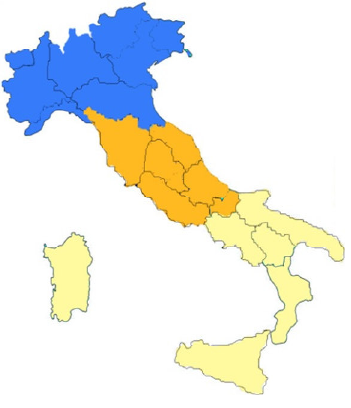
Legend Upper panel. The mortality rate in the south (9.3 ± 0.8%) and central regions (10.3 ± 0.9%), were significantly lower than in the north (15.8 ± 1.4%) (P<0.001 and P=0.002 respectively). There was no significant difference between the central and southern regions (P=0.448). Middle panel. The southern region had the highest prevalent use of AV fistula (85.6 ± 1.3%) followed by the central region (81.2 ± 2.0%) and the north (77.7 ± 2.1%). The difference achieved statistical significance between the southern and northern regions (P<0.001) but not between the central and the north (P=0.231) or the central and the south (P=0.077). Lower panel. The southern region had increased prevalence of diabetic patients (21.9 ± 1.3%), as compared to both the northern region (16.0 ± 1.7%; P=0.015) and the central region (16.9 ± 1.4%; P=0.033). The central and northern regions were not statistically different from each other regarding diabetes prevalence (P=0.656). * statistical significance of P < 0.05. Differences between groups were determined by ANOVA followed by un-paired t- tests.